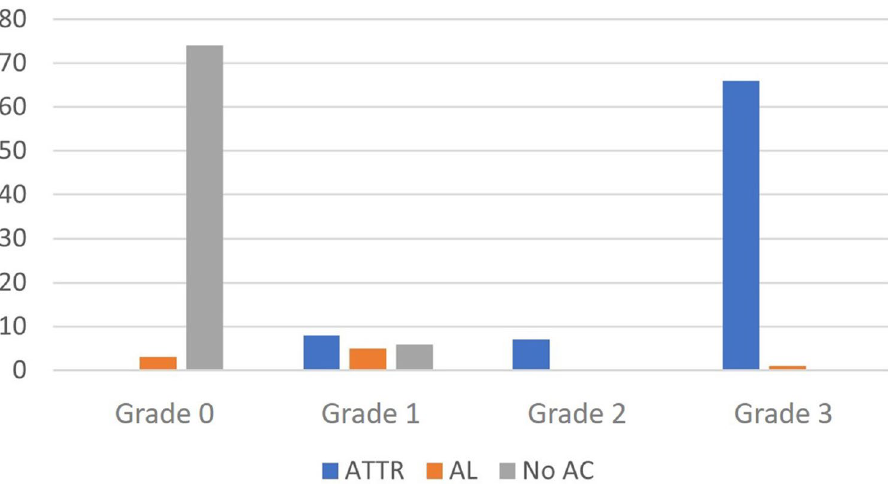
Figure 1. Relationship between the visual score and the definitive diagnosis of each